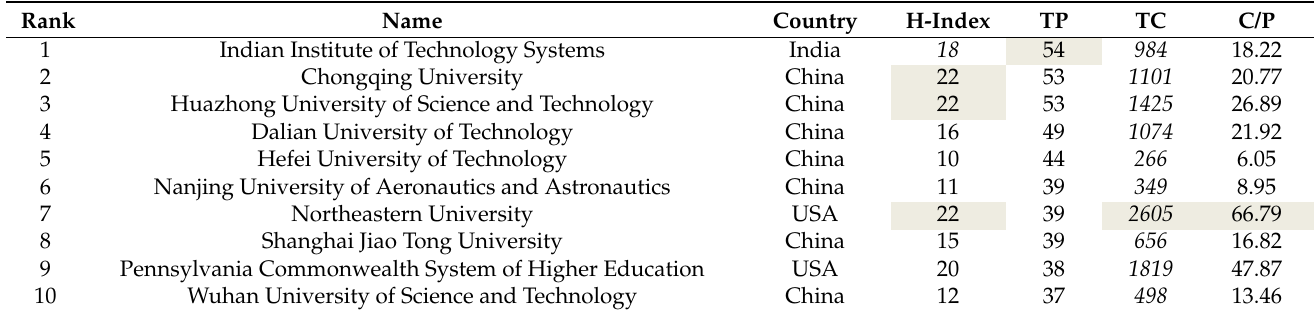
Table 7. Most productive and influential institutions in remanufacturing